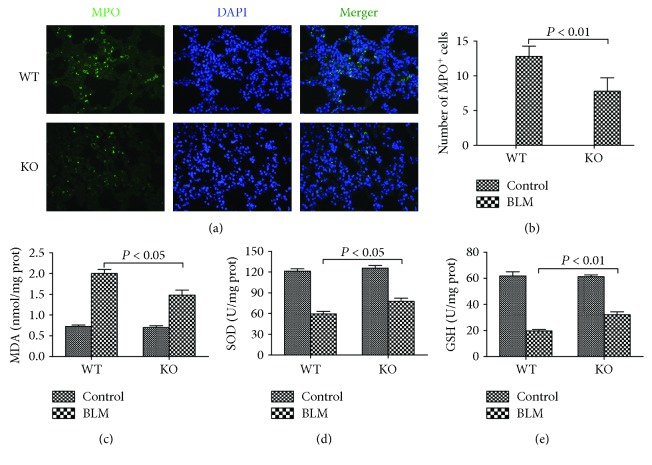
Effect of 5-HT on neutrophil infiltration and oxidative stress induced by bleomycin in mice. Intratracheal instillation of bleomycin (BLM) hydrochloride was performed to induce pulmonary fibrosis in wild-type C57BL/6 (WT) and TPH1 knockout (KO) mice. The mice in the WT and KO control, WT BLM, and KO BLM groups were sacrificed on day 21. Lung tissues were collected to perform immunofluorescent staining to detect the location of (a) myeloperoxidase (MPO) and the calculation of (b) MPO positively stained cells. Meanwhile, the lung (c) malondialdehyde (MDA), (d) superoxide dismutase (SOD), and (e) glutathione (GSH) levels were examined to determine the severity of oxidative stress. All data were expressed as mean ± SD, n = 6.